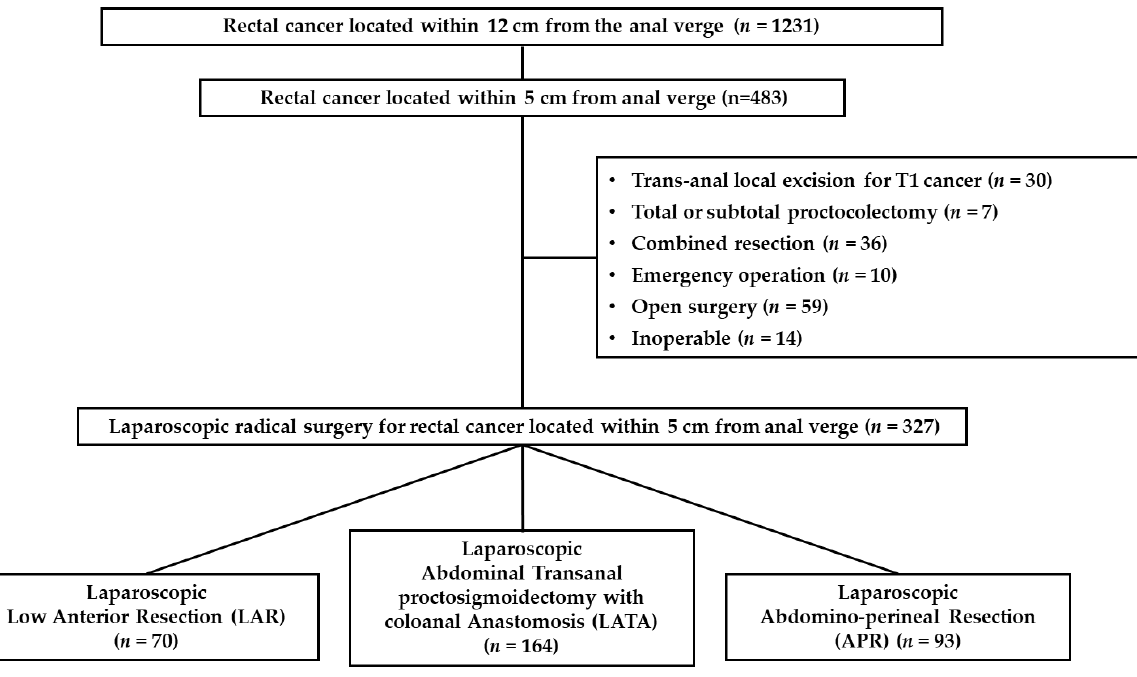
Figure 1. Flowchart of the inclusion process.